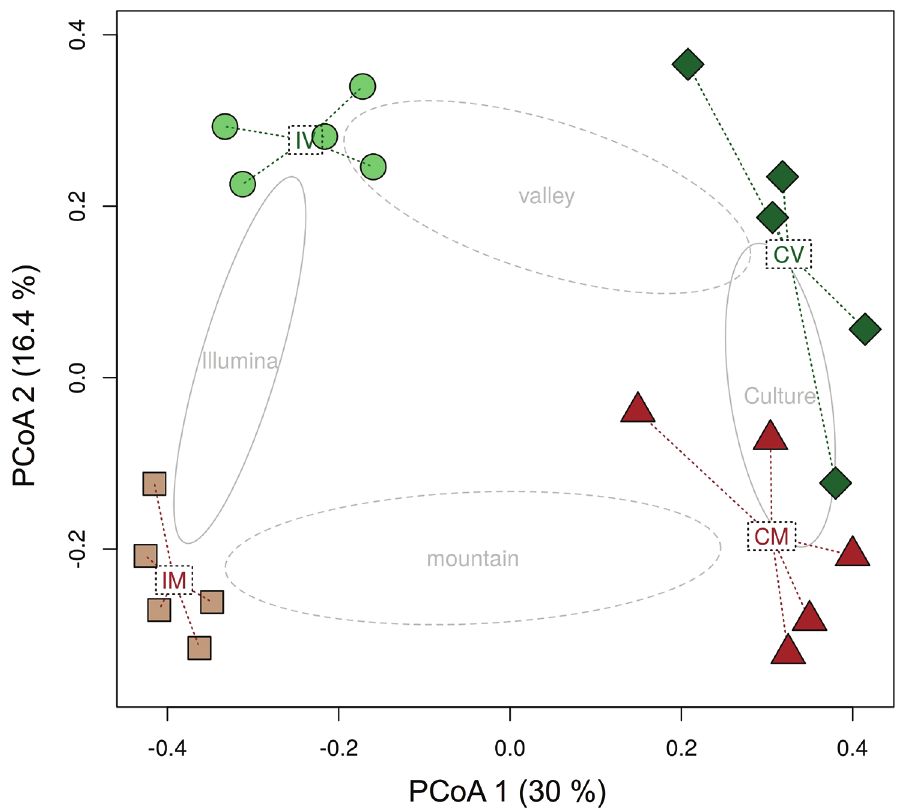
Figure 2 . Principal coordinate analysis (PCoA) of fungal leaf-inhabiting endophytes of beech display strong- ly differing assemblages obtained with Illumina sequencing and cultivation. Both methods revealed differing mycobiomes from valley and from mountain leaves, although these differences were less pronounced for cultivation data. Abbreviations: IM = Illumina data from mountain samples, IV = Illumina data from valley samples, CM = cultivation data from mountain samples, CV = cultivation data from valley